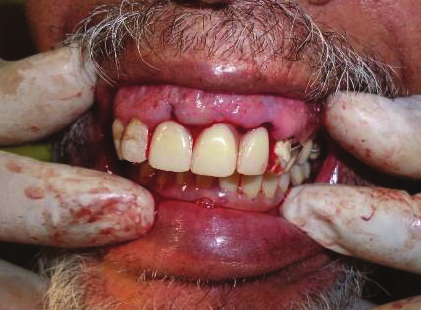
Figure 4: After insertion of maxillary and mandibular immediate